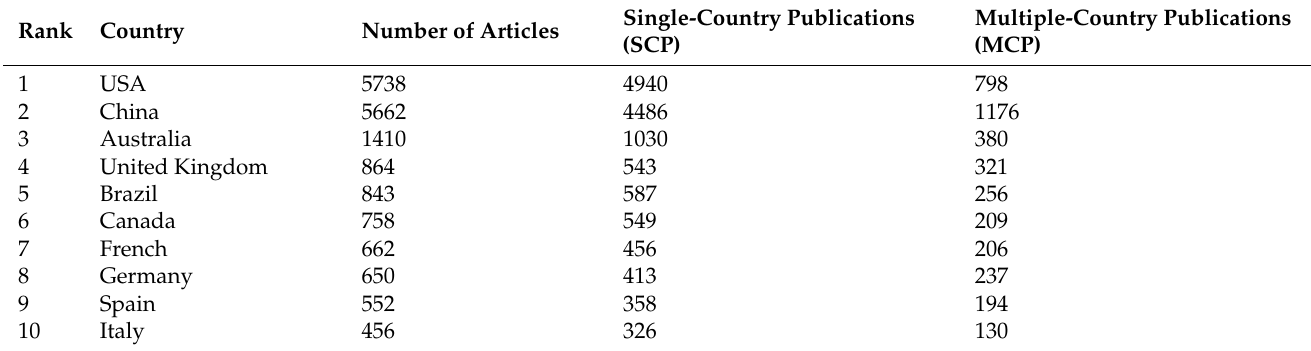
Table 2. Top 10 countries in terms of the literature volume in the field of ecological